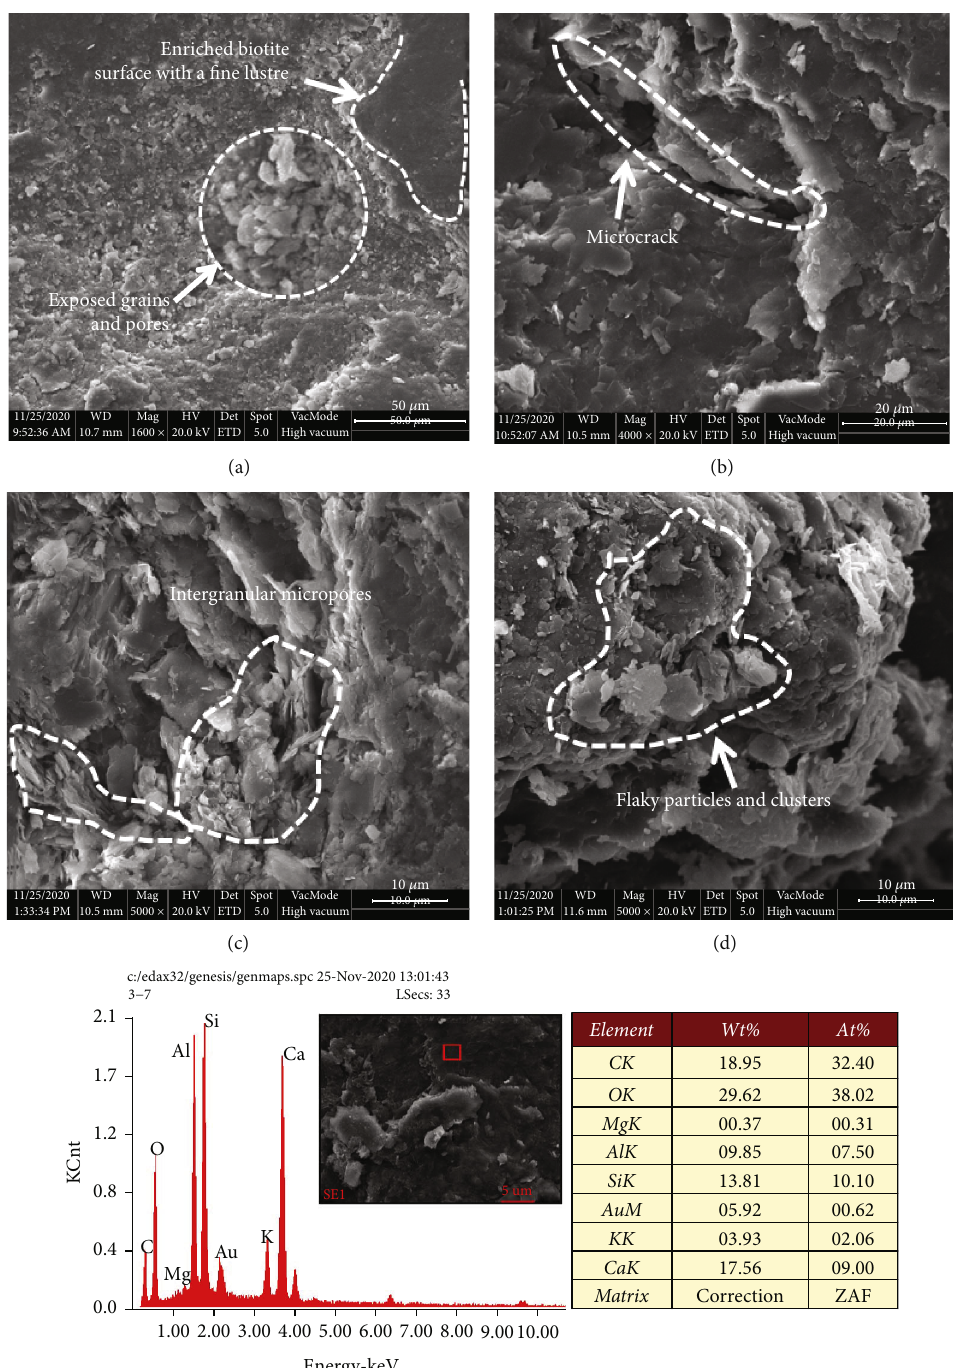
Figure 4: SEM-EDS images in samples. (a) The grains and particles. (c) Micropores in the fracture section. (b) The microcracks in the surface. (d) The particles and clusters. (e) The energy spectrum of elements and its